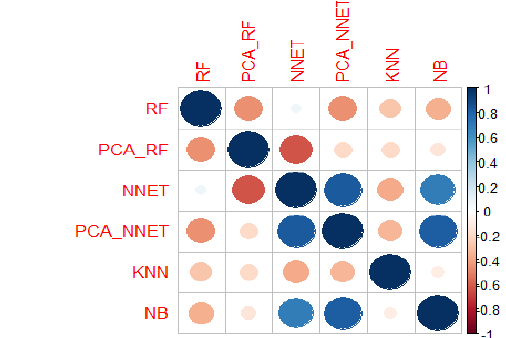
Figure 4. Performance Evaluation